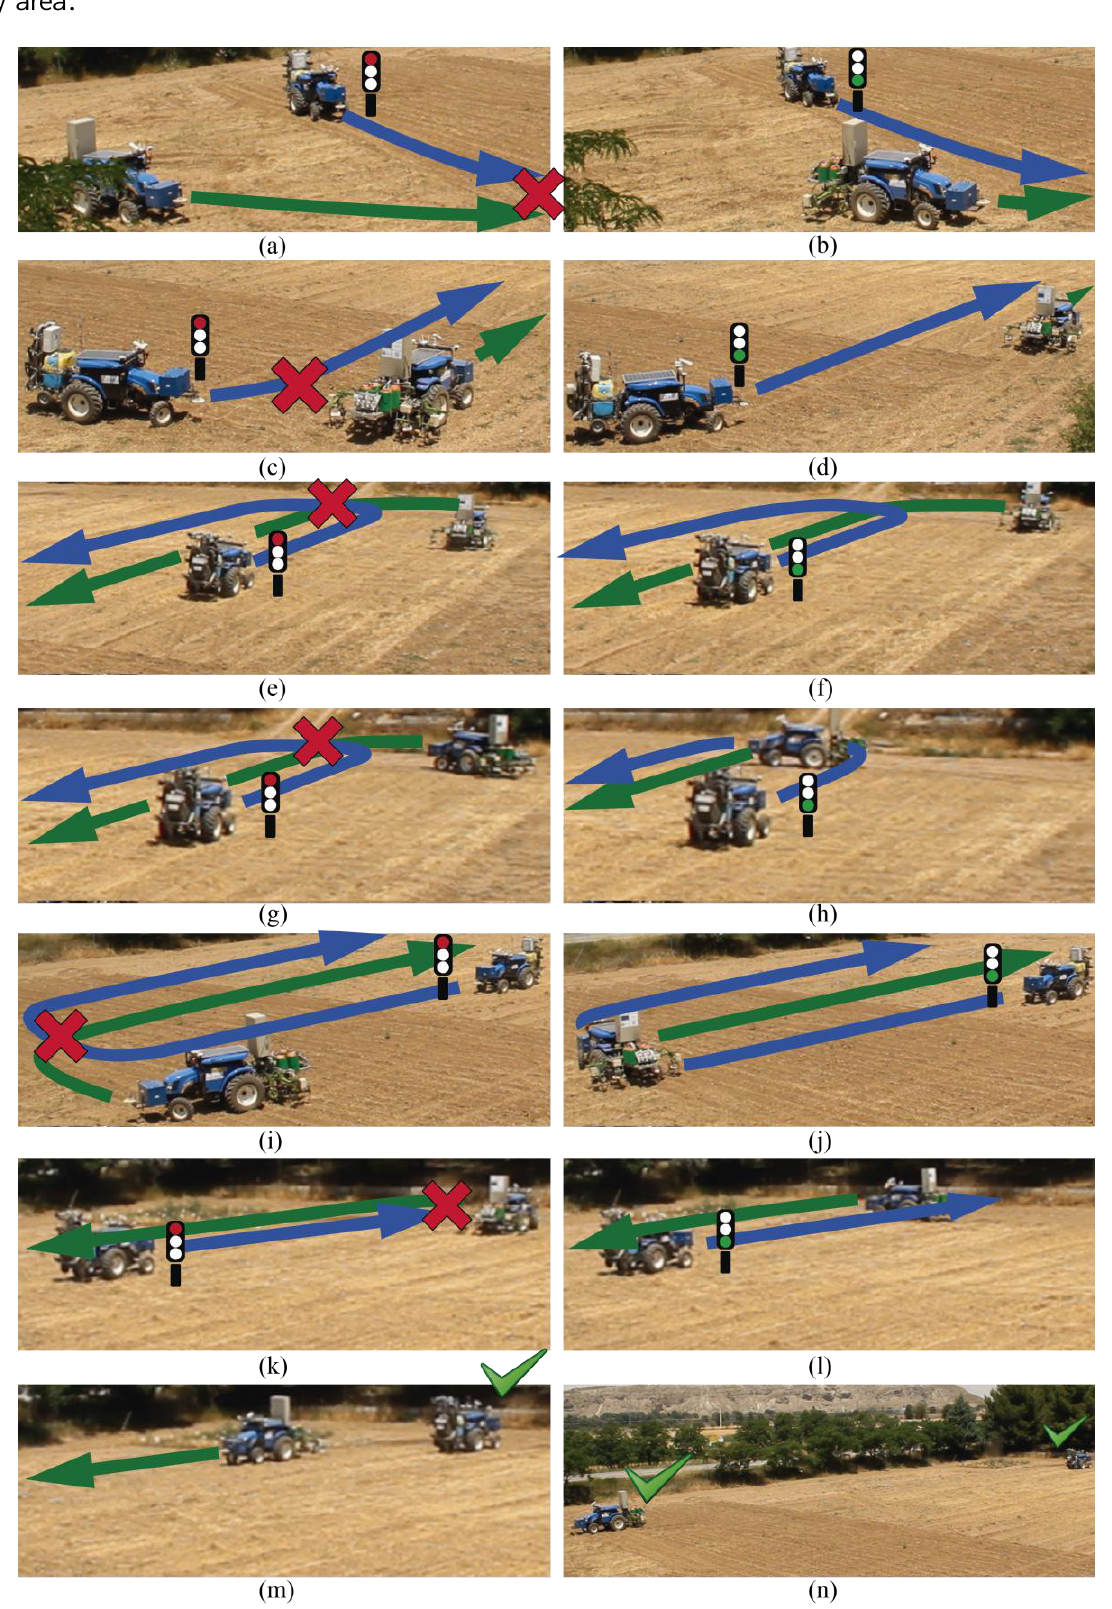
Figure 14. Mission timeline. ( a – l ) Collisions dealt with by pause and resume operations, and ( m – n ) final positions of the